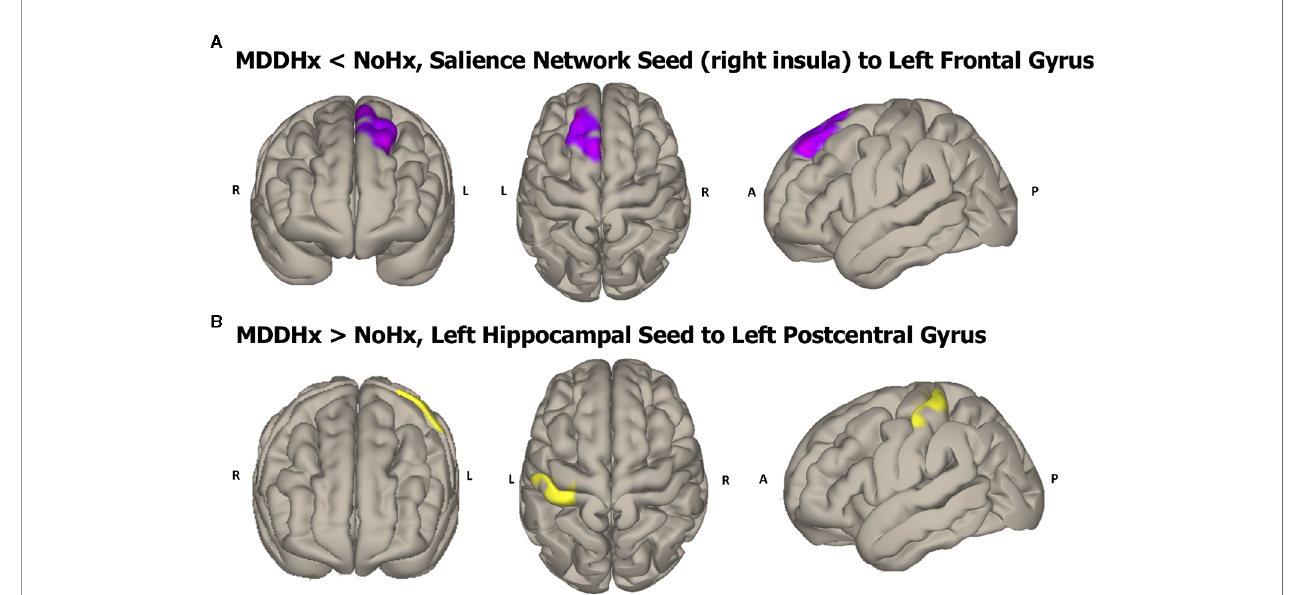
FIGURE 1 | Visualization of the approximate anatomical location of connectivity differences between groups. (A) The MDDHx group exhibited decreased functional connectivity between the SN seed (right insula) and the left superior frontal gyrus compared to the NoHx group. (B) MDDHx exhibited increased functional connectivity between the left hippocampus seed and the left postcentral gyrus. SN, salience network; NoHx, No history of depression; MDDHx, History of depression; L, left hemisphere; R, right hemisphere; A, anterior; P, posterior.